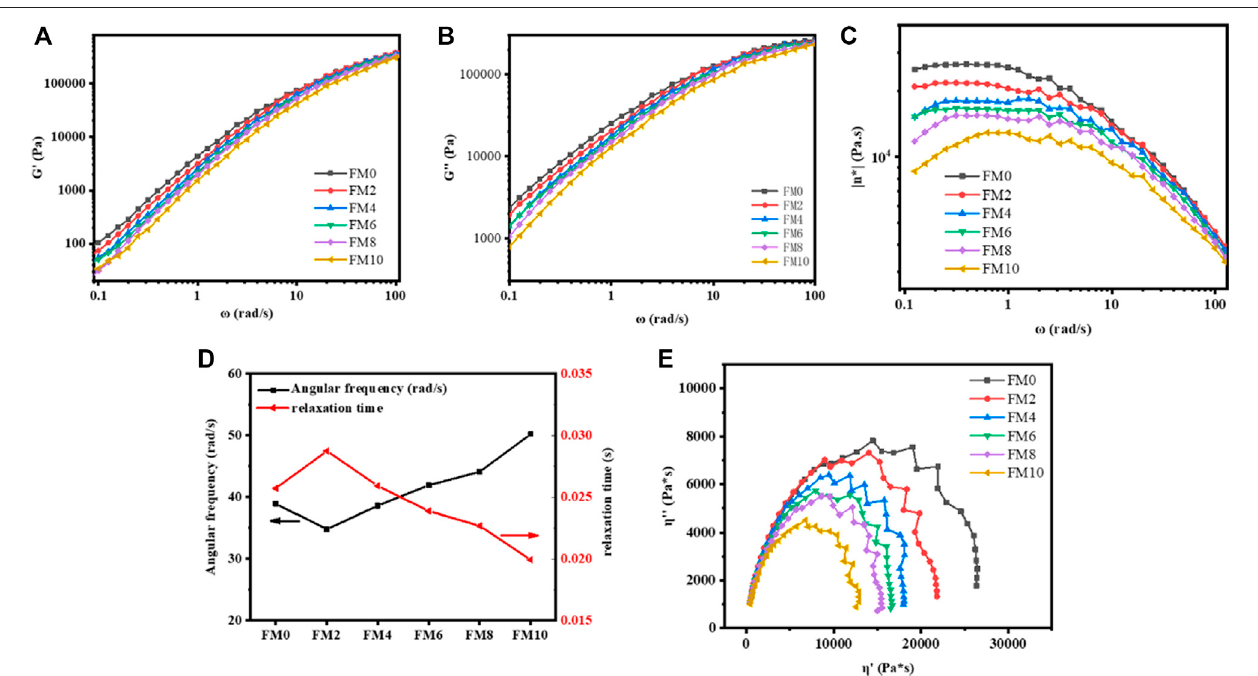
FIGURE 8 | (A) Storage modulus, (B) loss modulus, and (C) complex viscosity of PCTFE and PCTFE/FCO blends as a function of angular frequency measured at 240 ° C; (D) characteristic frequency and relaxation time of PCTFE and PCTFE/FCO blends; (E) Cole – Cole curves of PCTFE and PCTFE/FCO blends.